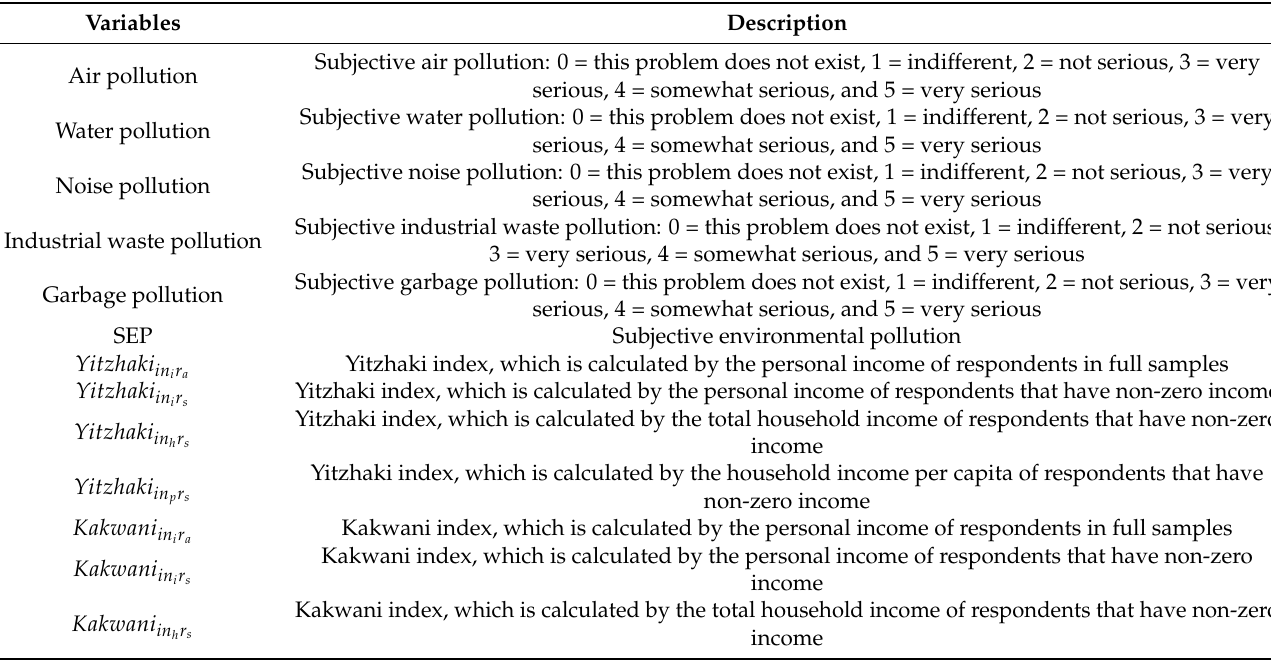
Table A5. Variable